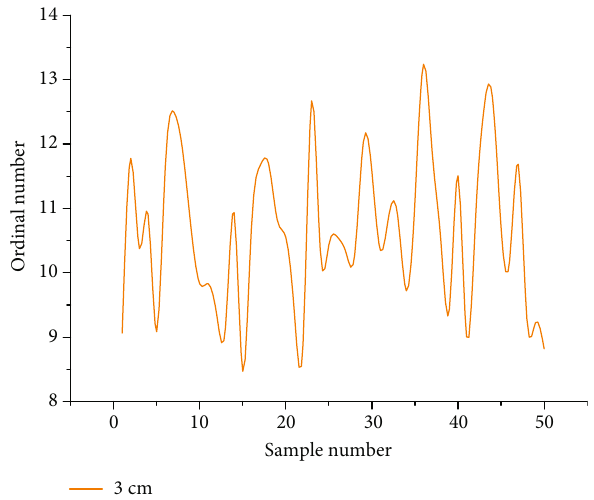
Figure 8: Identi fi cation coe ffi cient with defect thickness of